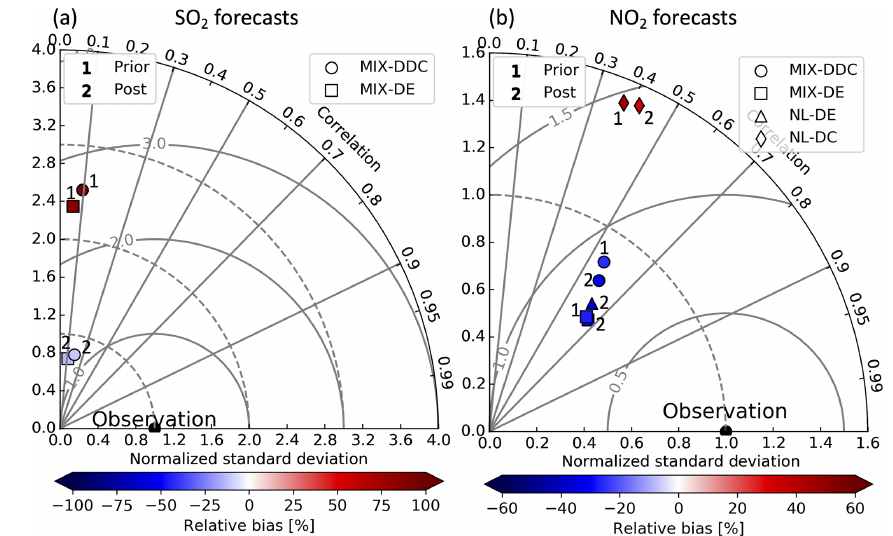
Figure 13. Taylor diagrams of evaluations of surface SO 2 (a) and NO 2 (b) forecasts with in situ observations. Circle 1 represents AQF- MIX-DDC-PRI, circle 2 AQF-MIX-DDC-POS, square 1 AQF-PRI, square 2 AQF-MIX-DE-POS, triangle 2 AQF-NL-DE-POS, diamond 1 AQF-NL-DC-PRI, and diamond 2